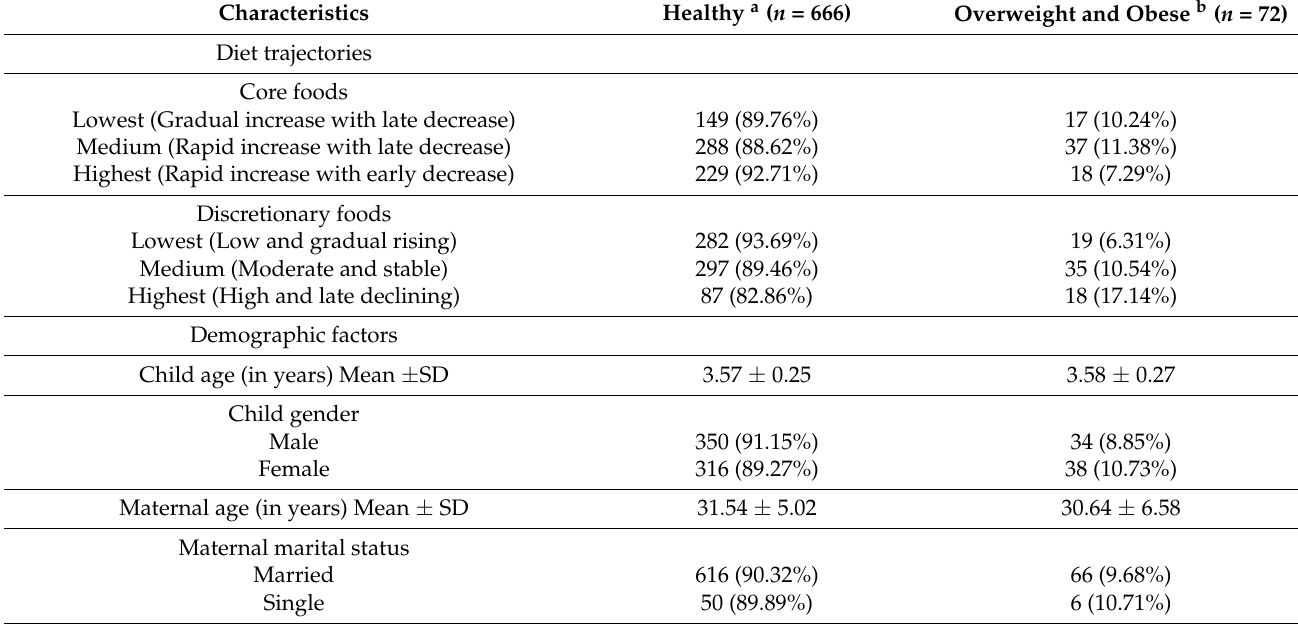
Table 1. Participant characteristics—diet trajectories, demographic, socioeconomic, behavioural, and biological characteris- tics based on anthropometric groups ( n =